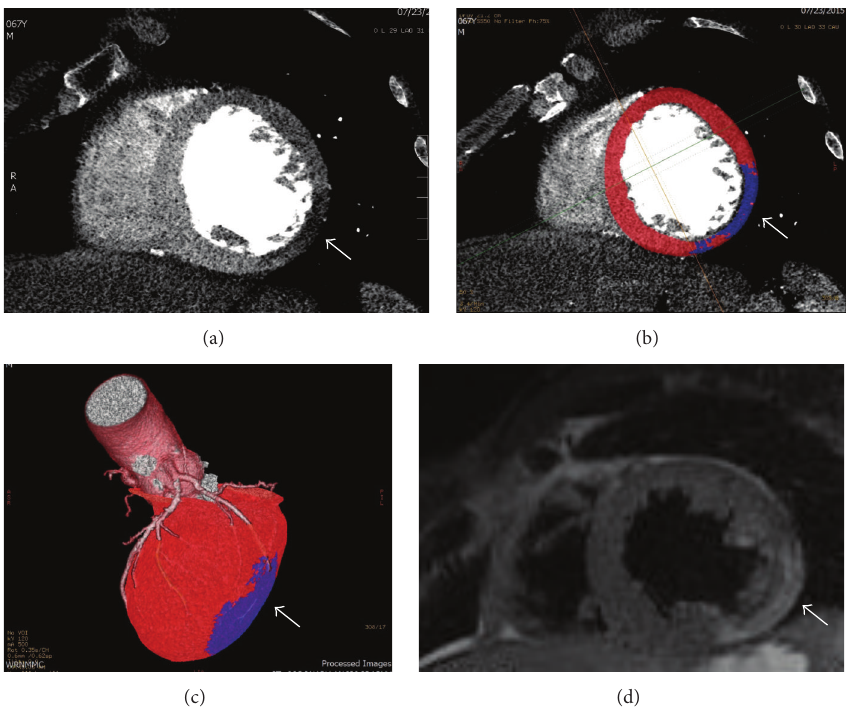
Figure 2: Short-axis first-pass CT perfusion images demonstrating an area of low attenuation of the mid inferolateral wall (a, b, c) corresponding to infarct on cardiac MRI delayed enhancement (d)